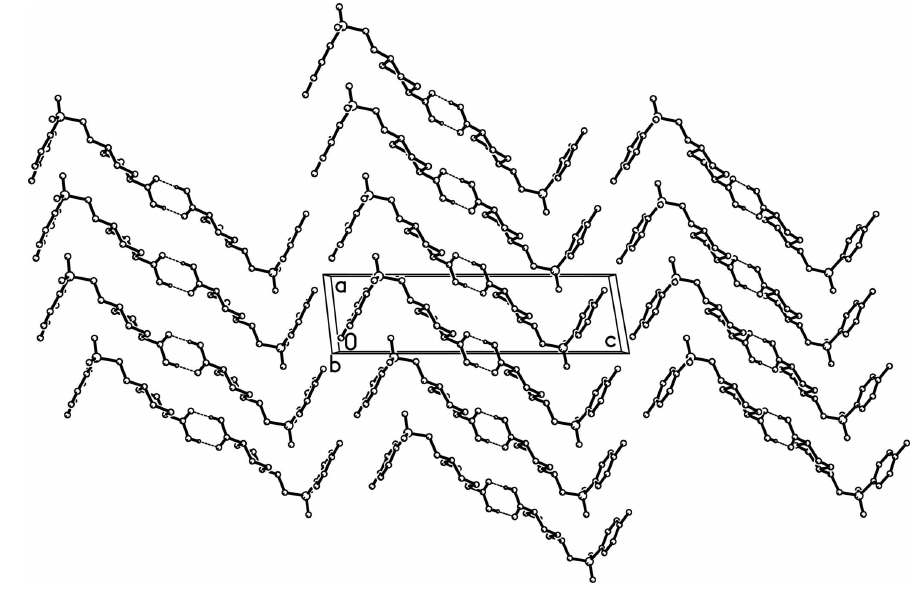
The molecular structure of the title compound, with displacement ellipsoids drawn at the 20% probability level.